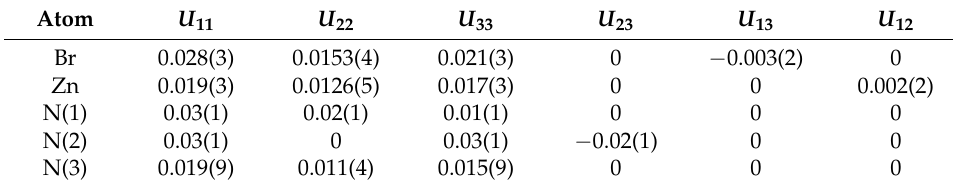
Table A2. Anisotropic displacement parameters U ij (10 4 pm 2 ) for [Zn 2 (NH 3 ) 2 (NH 2